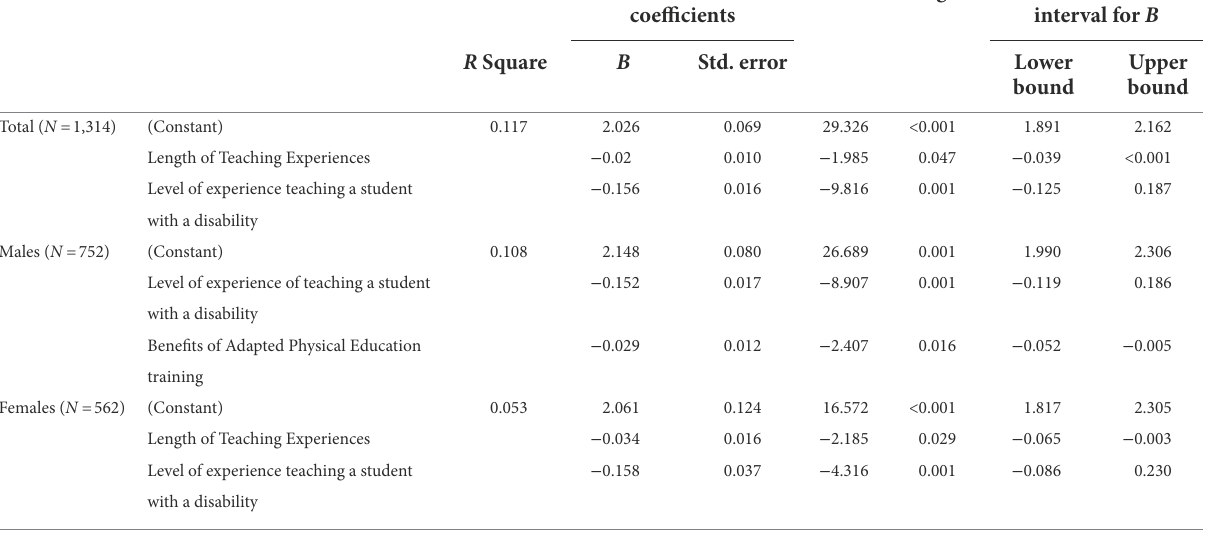
TABLE 3 Multiple linear regression analysis for the associations between attitudes toward inclusion and age, and sociodemographic variables among PE teachers, stratified by